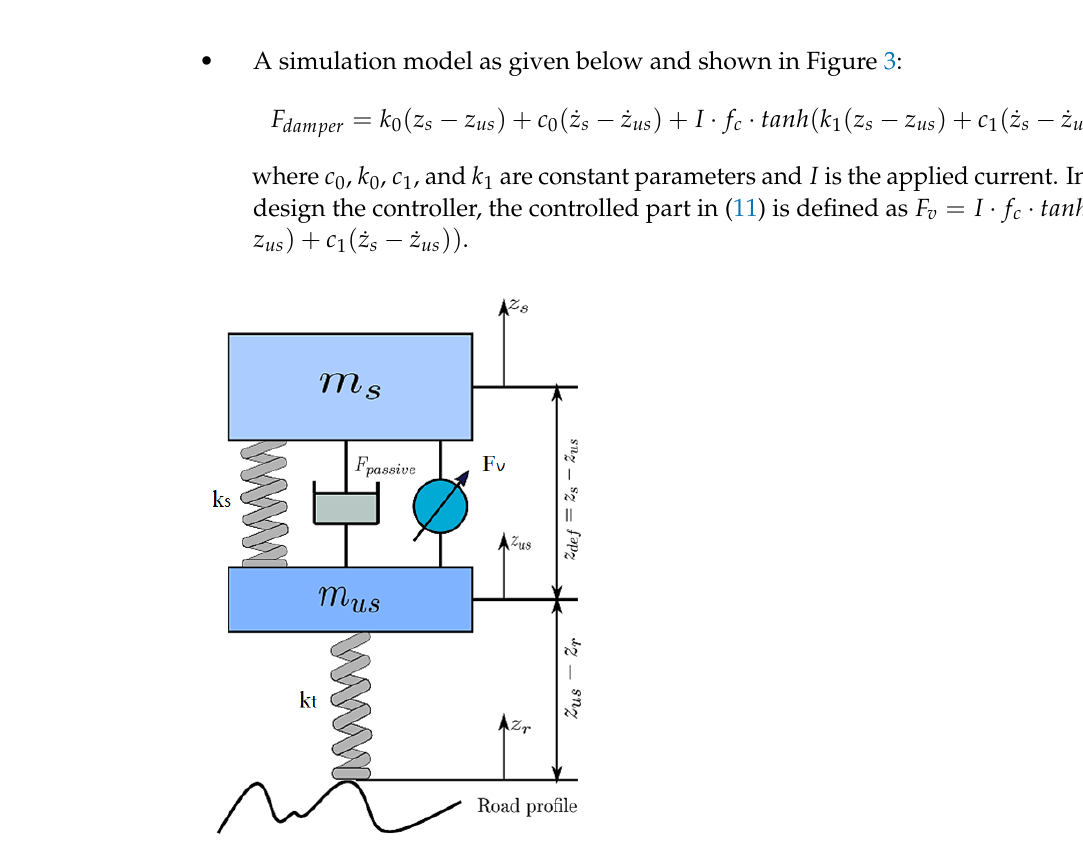
Figure 2. The quarter-car model for an illustration of vehicle vertical dynamics.